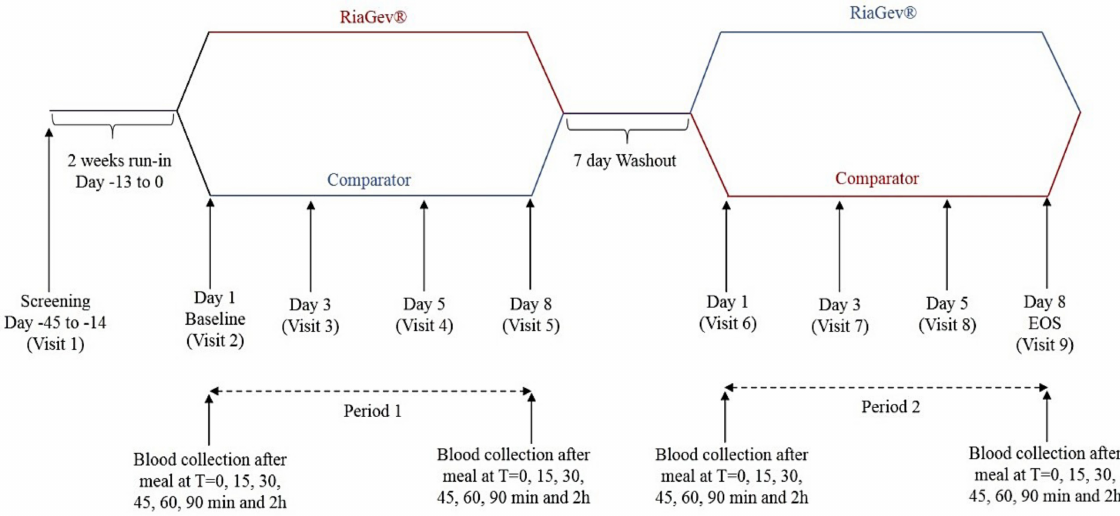
Figure 1. Clinical Trial Design During this randomized, triple-blind, placebo-controlled, crossover study, either RiaGev or Placebo (Comparator) was administered from Day 1 through Day 8.